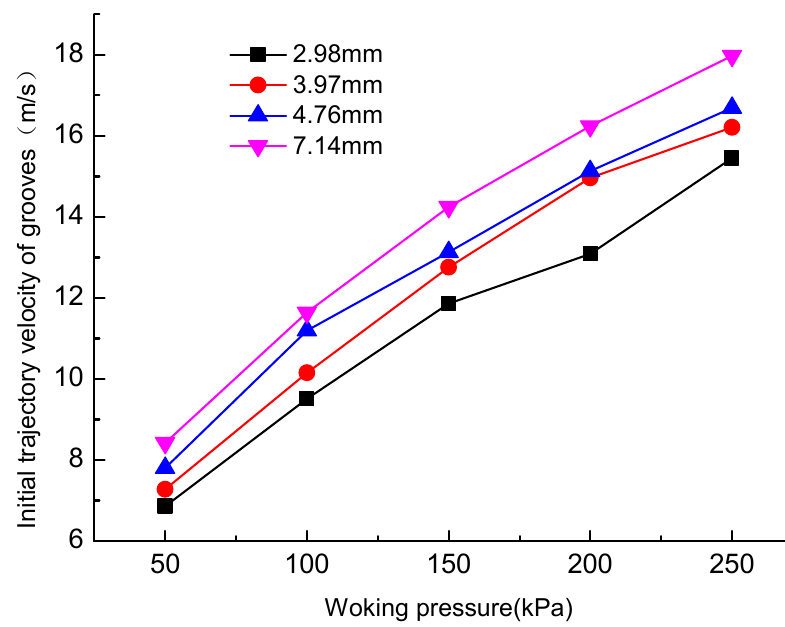
Water 2018 , 10 , x FOR PEER REVIEW Figure 7. Numerical results of initial trajectory velocity at different nozzle diameters.